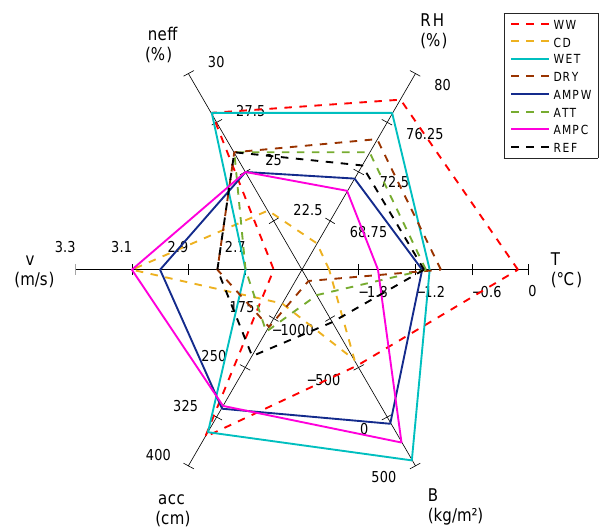
Figure 7. Spider plot showing the annual variable space of the indi- vidual climate scenarios. Solid (dashed) lines depict scenarios caus- ing positive (negative) mass balances for the current extent of LG. Variable abbreviations are explained in Table 4. The REF year has similar characteristics as scenarios DRY and ATT, underlining the current accumulation deficit. Positive mass balances are a result of abundant accumulation and a complex interplay between decreased (increased) humidity and cloudiness, favouring long-wave surface cooling (reducing